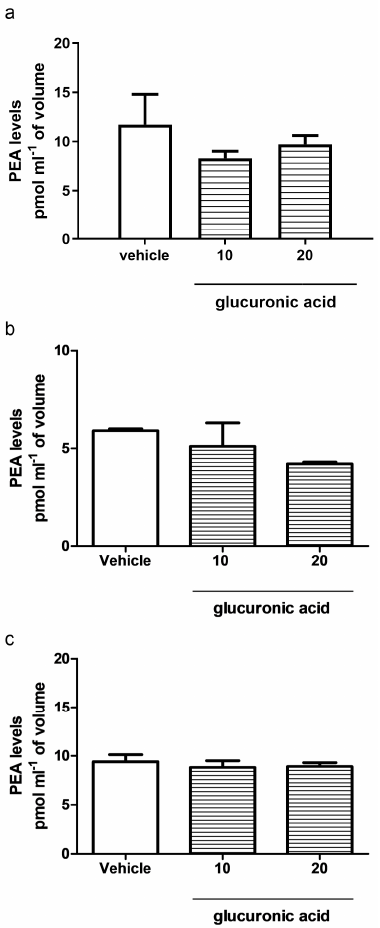
Figure 2. PEA levels in HaCaT keratinocytes after glucuronic acid treatment. PEA levels were measured in HaCaT keratinocytes treated for 40 min ( a ), 6 h ( b ), and 24 h ( c ) with glucuronic acid (10– 20 µ M). Data are representative of n = 4 separate determinations (means + s.e.m.). Statistical analyses were carried out using one-way ANOVA followed by the Newman–Keuls multiple comparison test.